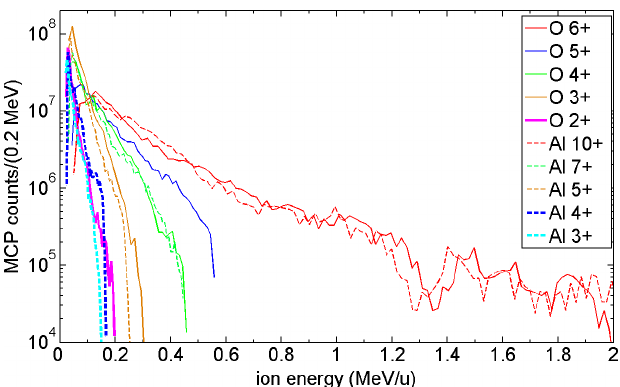
FIG. 6. Comparison of the accelerated oxygen and aluminum ions obtained from a shot on a 11 (cid:1) m thick Al foil. The ion traces of O 2 þ , Al 3 þ , and Al 4 þ could be analyzed individually while the other ion traces could only be analyzed as a summed particle signal due to superpositions. O 6 þ superposed with Al 10 þ were the ions exposed to the highest electric field potential with an acceleration of up to 1 : 94 MeV = u